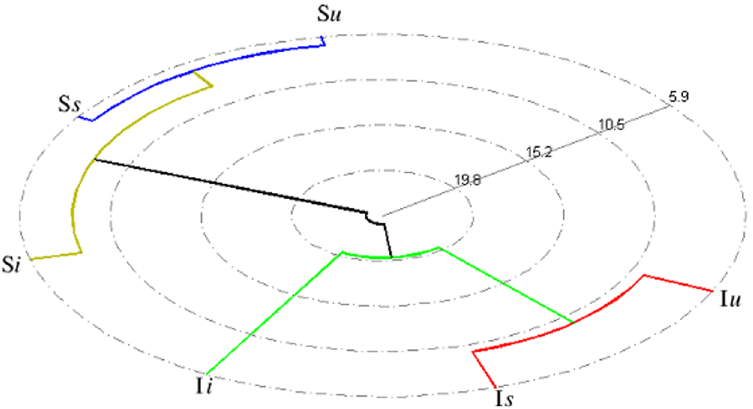
Fig 3. Polar dendrogram. Polar dendrogram showingdifferencesbetweenall the I treatments (I u , I i and I s ) and all the S treatments (S u , S i and S s ). Each treatment is an averageof five replicateswith each replicate consisting of 20